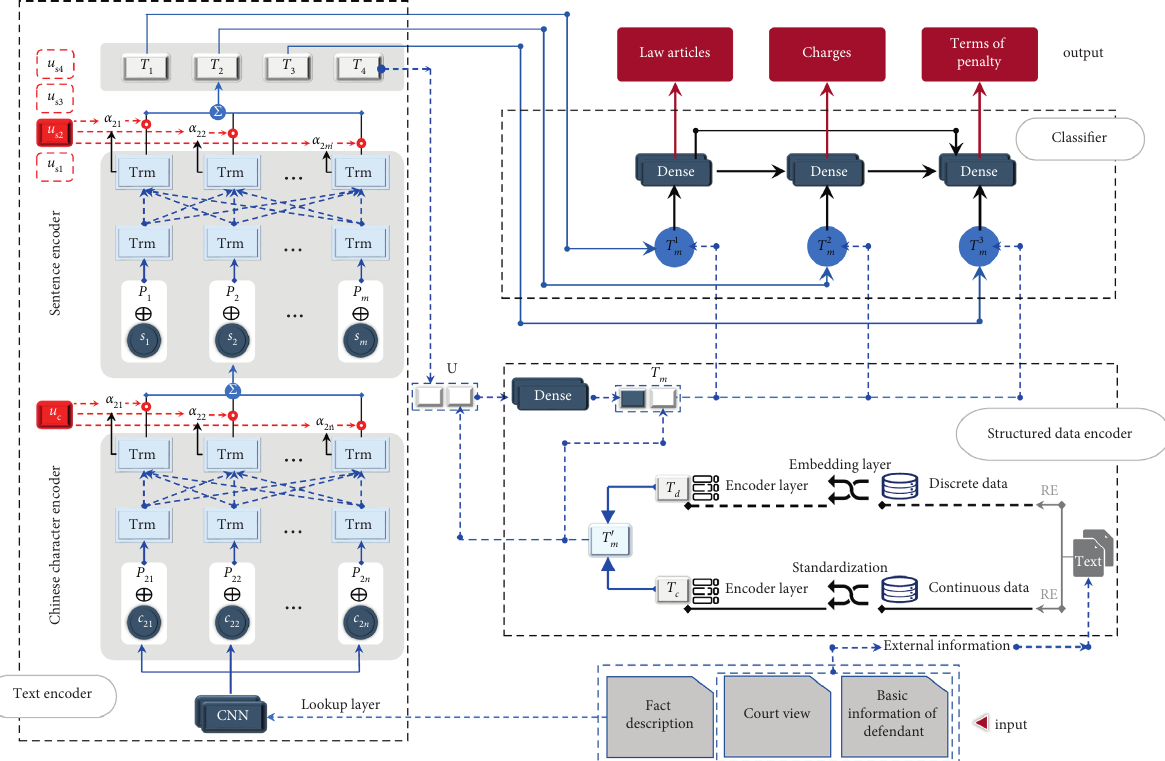
ic represents attention vector